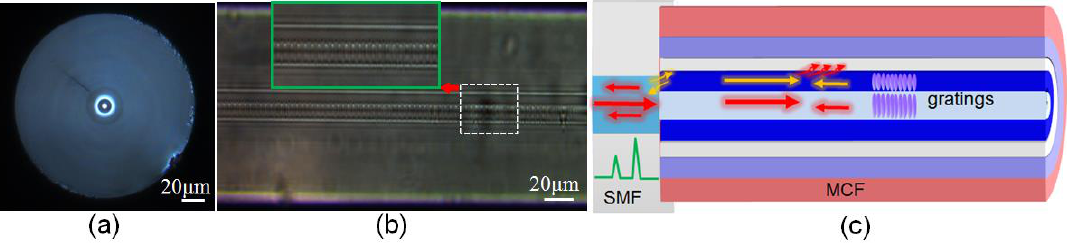
Figure 2. ( a ) Microscope image of the MCF cross-section. Inset shows the refractive index cross-section of the MCF. ( b ) Photomicrograph of the gratings; ( c ) Schematic diagram of mode-coupling inside